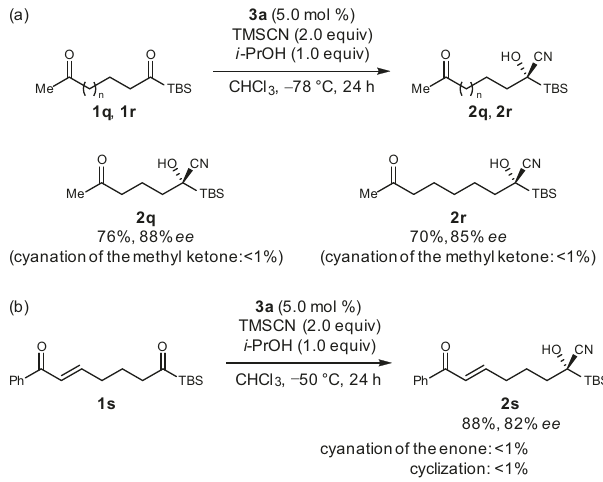
Fig. 8 Site- and enantioselective cyanation. a Cyanation of acylsilanes bearing methyl ketone moieties. b Cyanation of an acylsilane bearing an enone moiety.